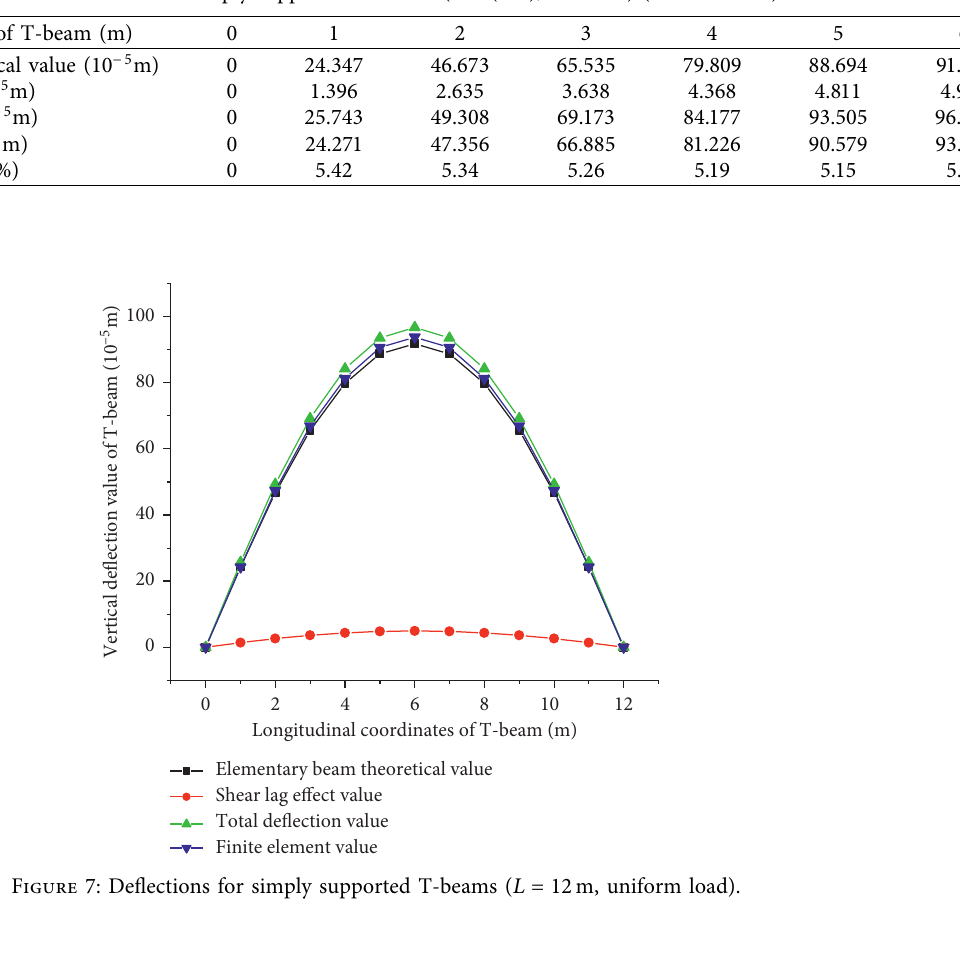
� 12m ,L � L � 6m, concentrated load). 1 2 3